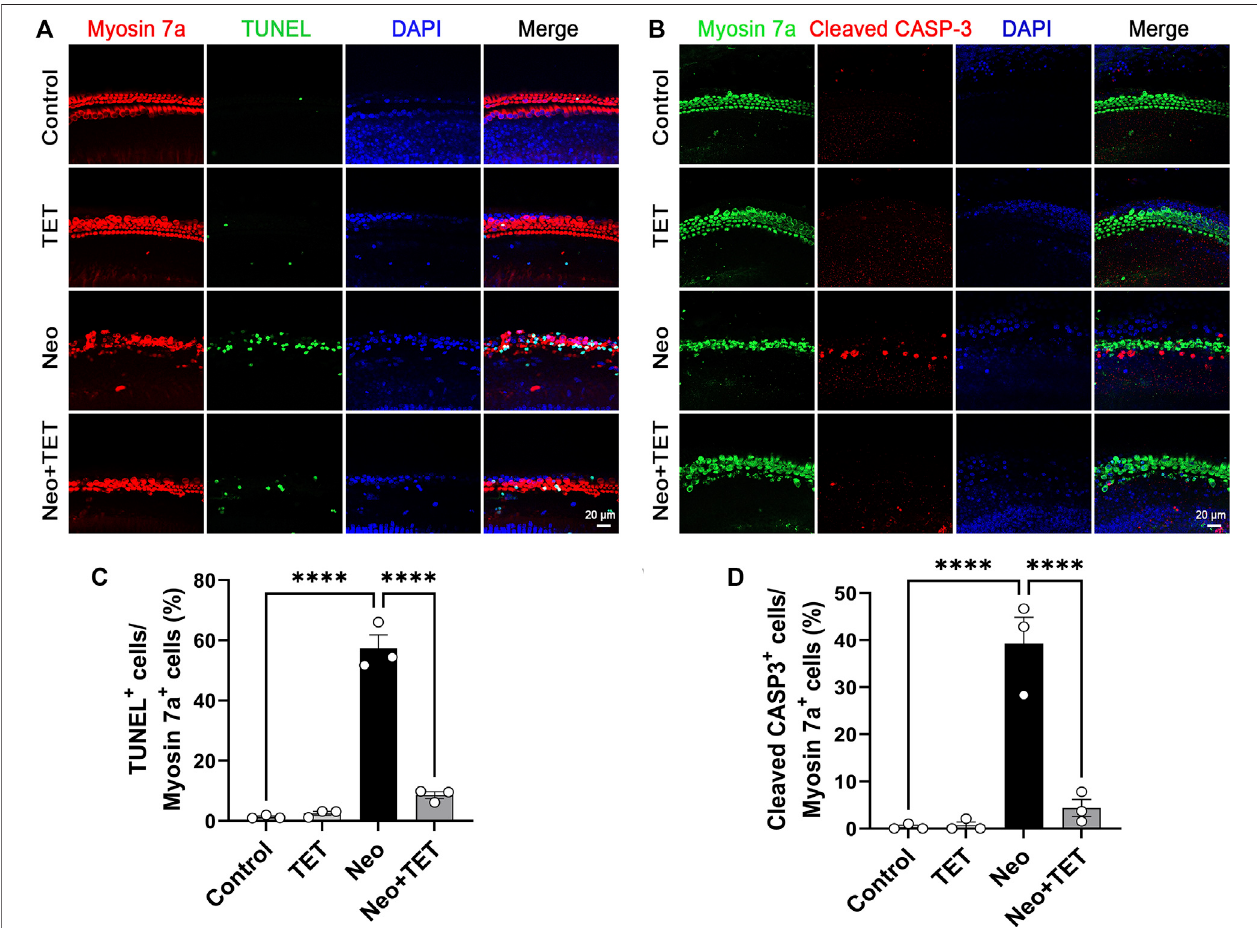
FIGURE 4 | Effects of TET on hair cell apoptosis in the mouse cochlea after neomycin exposure (A) Immuno fl uorescence staining with TUNEL and myosin 7a in cochlear hair cells in the middle turn after TET treatment followed by neomycin exposure. Scale bars: 20 μ m (B) Immuno fl uorescence staining with cleaved caspase-3 and myosin 7a in cochlear hair cells in the middle turn after TET treatment followed by neomycin induction. Scale bars: 20 μ m (C) Quanti fi cation of the numbers of TUNEL/myosin 7a double-positive cells in (A) (n = 3) (D) Quanti fi cation of the numbers of cleaved caspase-3/myosin 7a double-positive cells in (B) (n = 3). **** p <